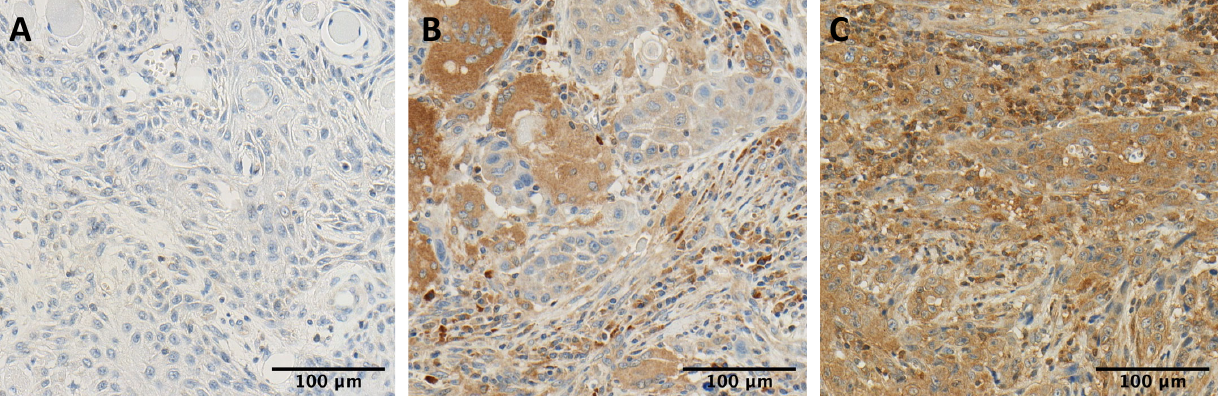
Figure 1. Staining patterns for TRIM21 in HNSCC. We evaluated TRIM21 expression in HNSCC samples from our cohort using immunohistochemistry. We observed heterogenous intratumoral staining patterns, meaning both positive and negative cells were observed within the patients’ samples. In ( A ), tumor cells show no positive staining with TRIM21. In ( B , C ), the tumor cells show a positive cytoplasmatic staining with TRIM21.